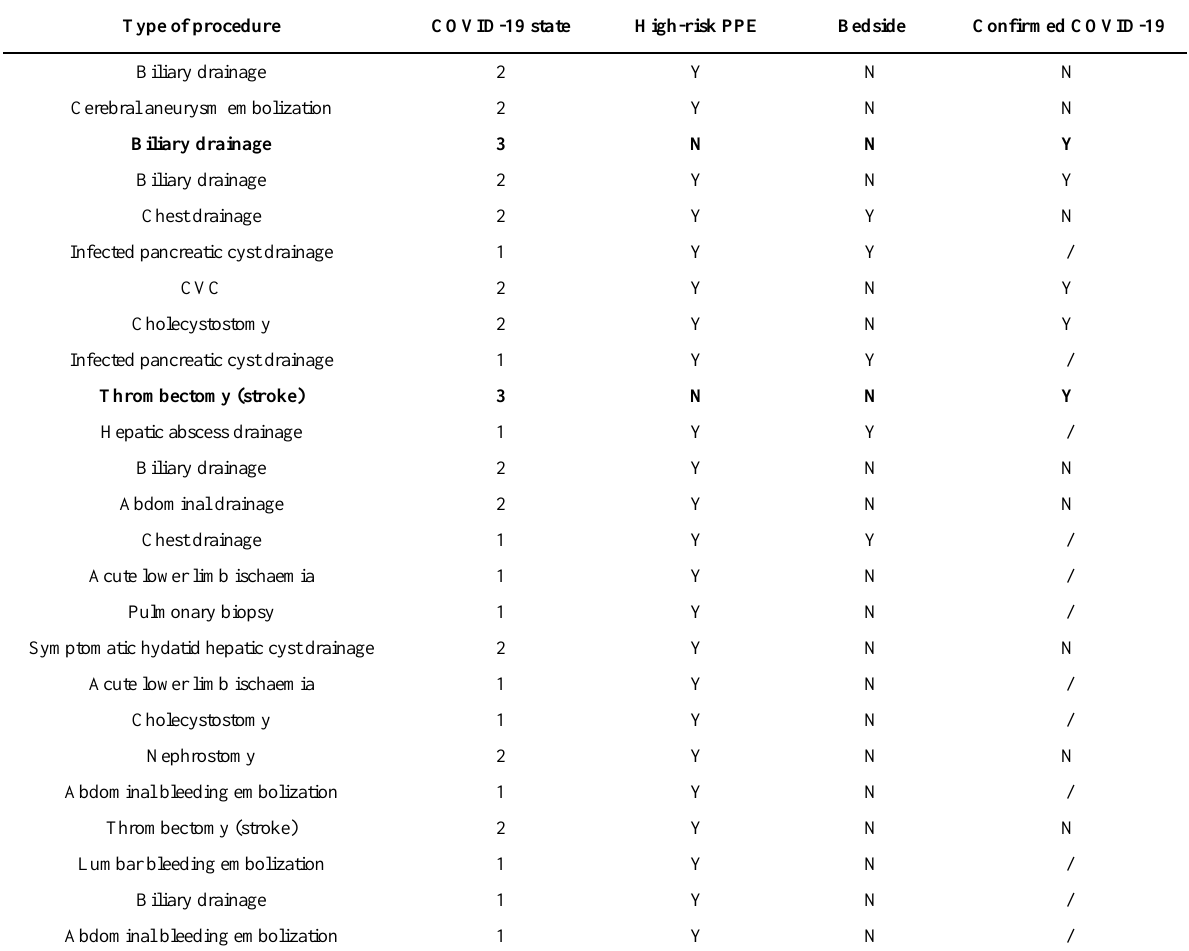
Table 2. Specific type of each procedure performed on high risk patients between the 25th of February and the 14th of April 2020, sort by date. Two of them (bold) were not initially suspected for COVID-19, but they were diagnosed after